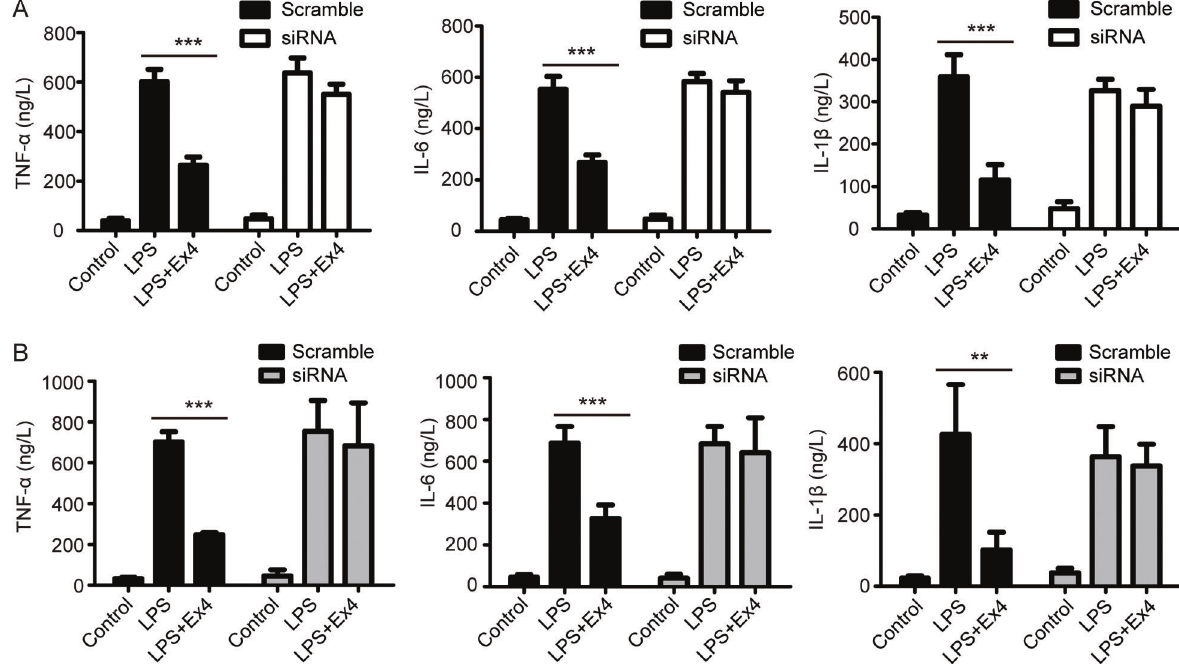
Figure 3. Effect of exendin-4 (Ex4) on the secretion of in fl ammatory macrophage cytokines. RAW264 cells ( A ) or mouse peritoneal macrophages ( B ) were treated with lipopolysaccharide (LPS) or a combination of LPS and Ex4 overnight, and then incubated in serum- free medium for 24 h. The secretion of TNF- a , IL-6, and IL-1 b was evaluated using enzyme-linked immunosorbent assay (ELISA). Data are reported as means ± SD. **P o 0.01; ***P o 0.001 (ANOVA).